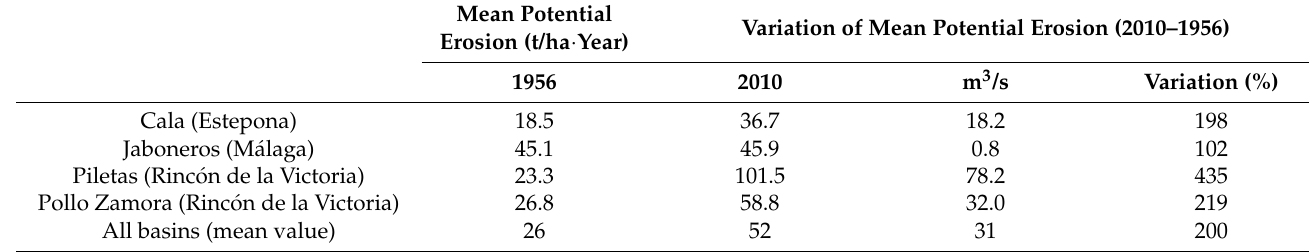
Table 8. Mean potential soil erosion according to RUSLE in 1956 and variation compared to 2010. Mean Potential